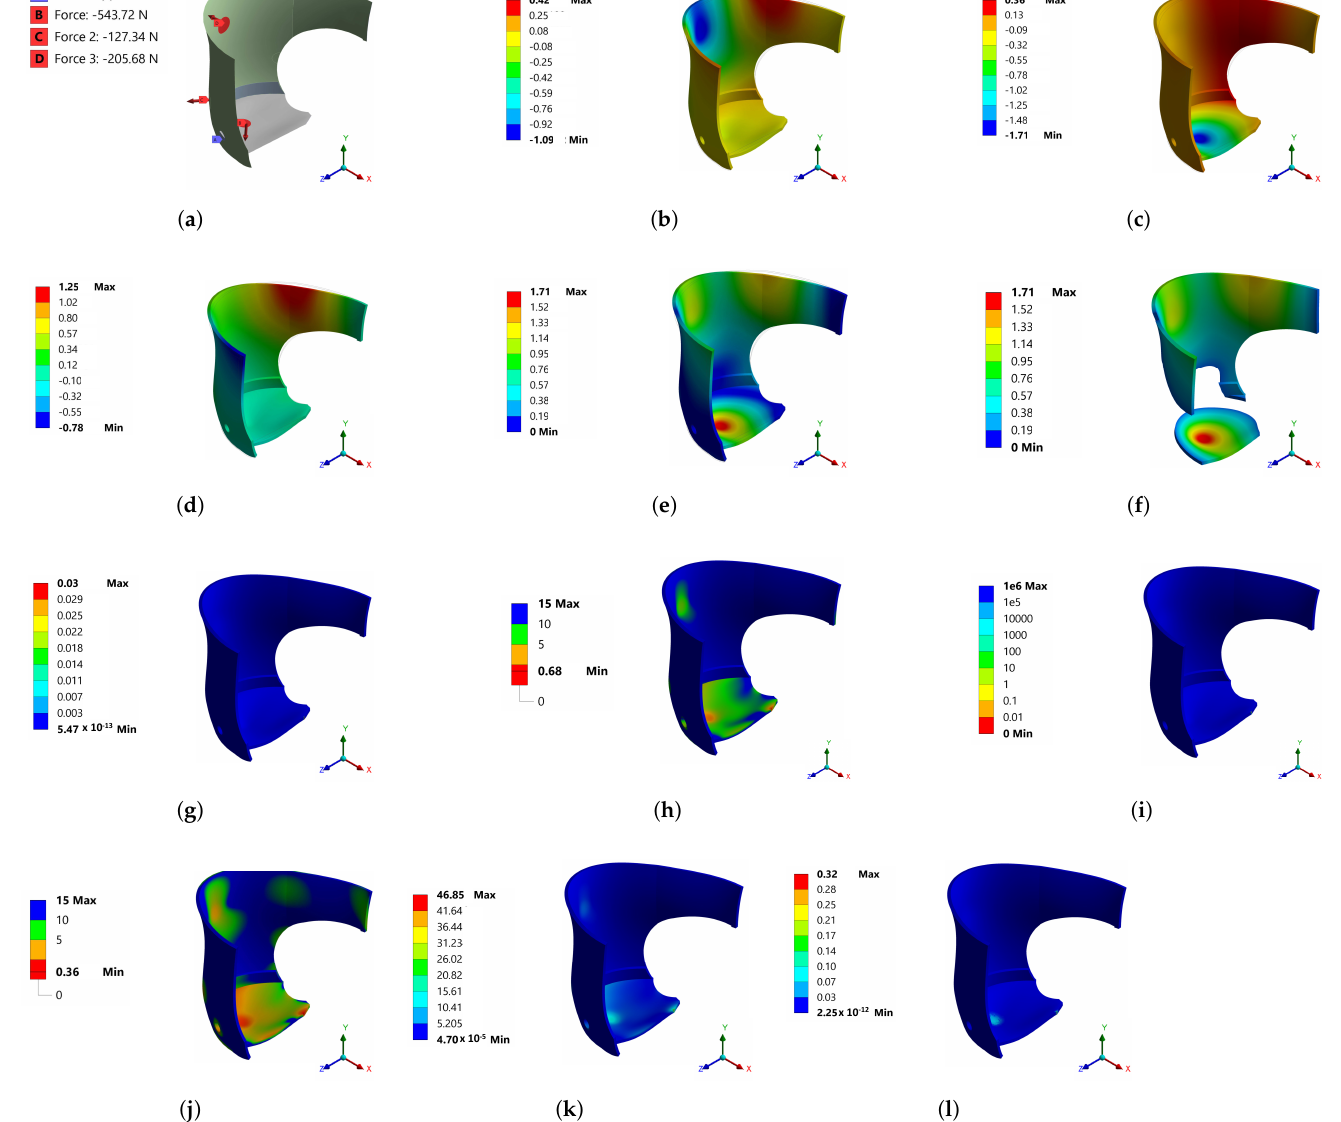
Figure 5. Mechanical behavior results for Model 1: ( a ) Boundary conditions; ( b ) directional defor- mation (mm) (x-axis); ( c ) directional deformation (mm) (y-axis); ( d ) directional deformation (mm) (z-axis); ( e ) total deformation (mm); ( f ) total deformation (mm), surfaces with greater deformation; ( g ) structural error (mJ); ( h ) safety factor; ( i ) Life; ( j ) safety factor; ( k ) equivalent stress (Mpa); ( l ) strain energy